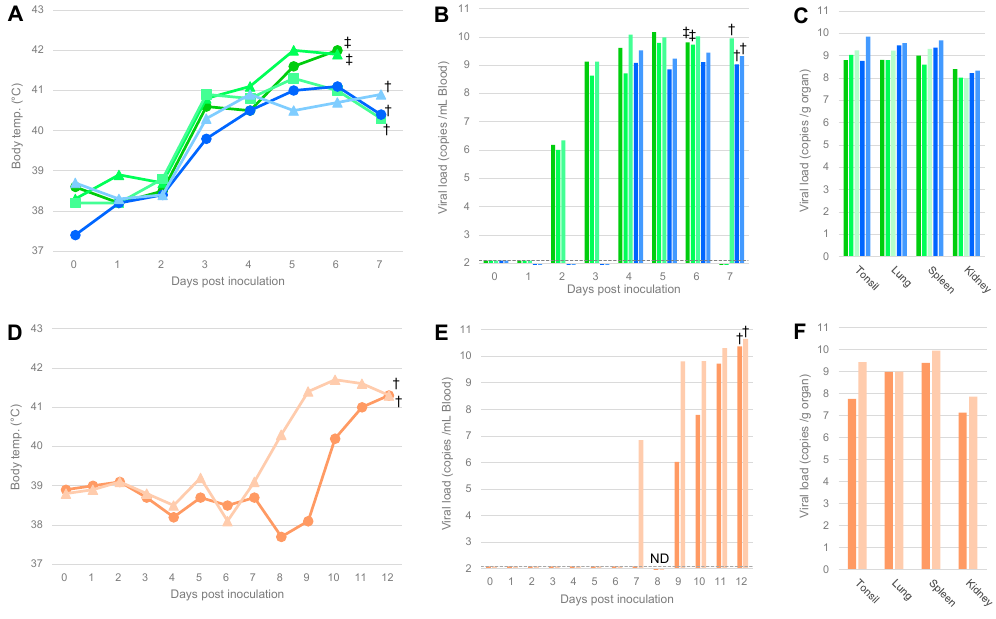
Figure 1. Body temperature and viral load of pigs inoculated with pork meat homogenates. The body temperature ( A , D ) and viral copy numbers in blood ( B , E ) and organs ( C , F ) of pigs inoculated with a 10% suspension of pork products are shown. Samples No. 1–21 (green) and 1–22 (blue) were from China ( A – C ), and sample No. 20901-1 (orange) was from the Philippines ( D – F ). The identifi- cation numbers of pigs are indicated by the shape of markers or sorting order of bars: Nos. 1, 2, and 3 are indicated by circles, triangles, and squares ( A ) or ordered from left to right ( B , C ), respectively. Each symbol means euthanasia by humane endpoint (†) or death (‡), and the broken lines in ( B , E ) indicate the detection limit (=100 copies/mL of blood). ND: not determined.